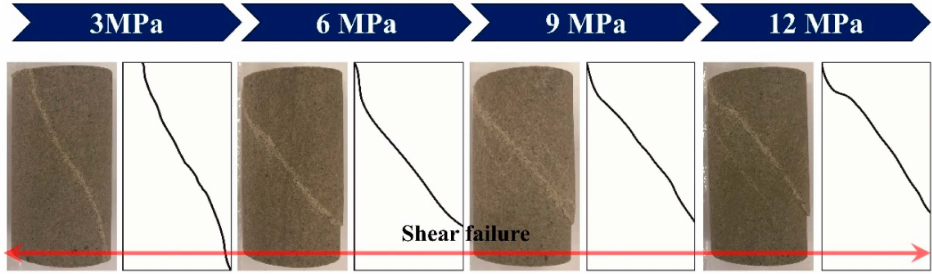
Figure 13. Failure modes of sandstone specimens at different confining pressures (20 F&T weathering